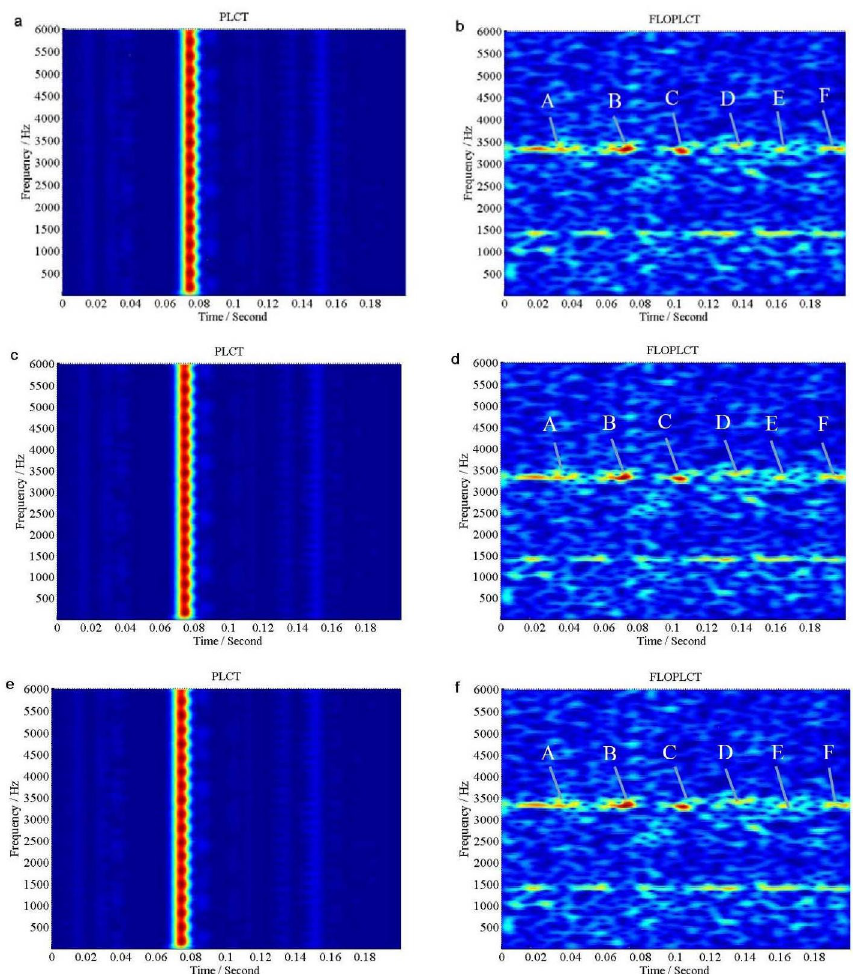
Fig 12. The time-frequency representations of the bearing ball fault in the position of DE data contaminated by α stable distribution noise (MSNR = 18 dB ). (a. The first time PLCT time-frequency representation; b. The first time FLOPLCT time-frequency representation; c. The second time PLCT time-frequency representation; d. The second time FLOPLCT time-frequency representation; e. The third time PLCT time-frequency representation; f. The third time FLOPLCT time-frequency representation).